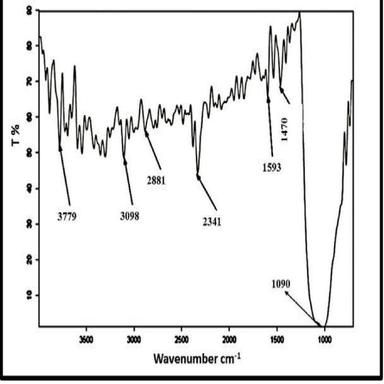
FTIR vibrational bands of geopolymer-epoxy hybrid material.